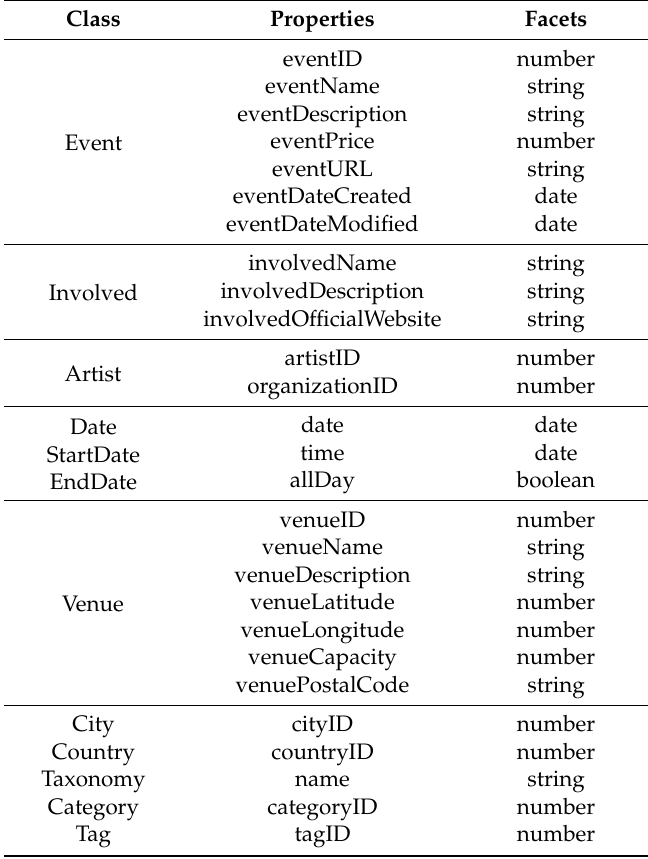
Table 1. Classes, properties and facets of LODSE